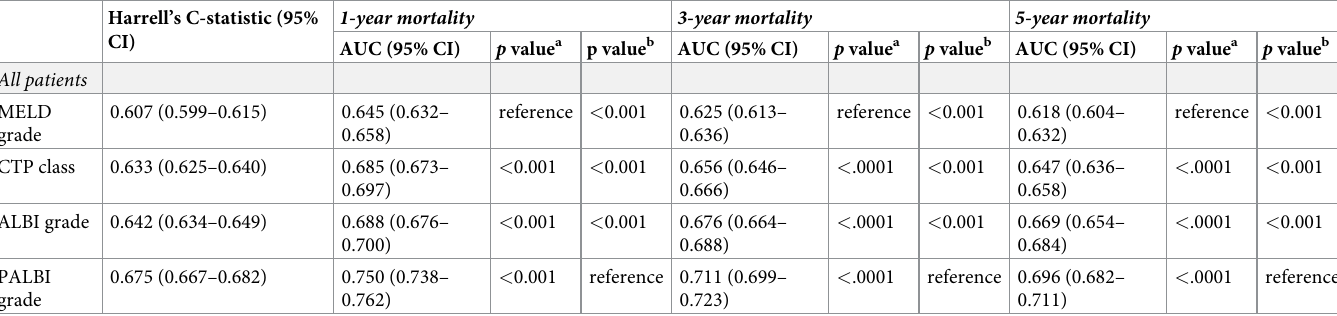
The predictive power of the ALBI and PALBI grades for OS was assessed according to curative treatment modality (SR, RFA, and LT; Fig 6). In patients undergoing SR, the ALBI grade was Table 3. AUC value and Harrell’s C-statics for comparing each grades. Harrell’s C-statistic (95%